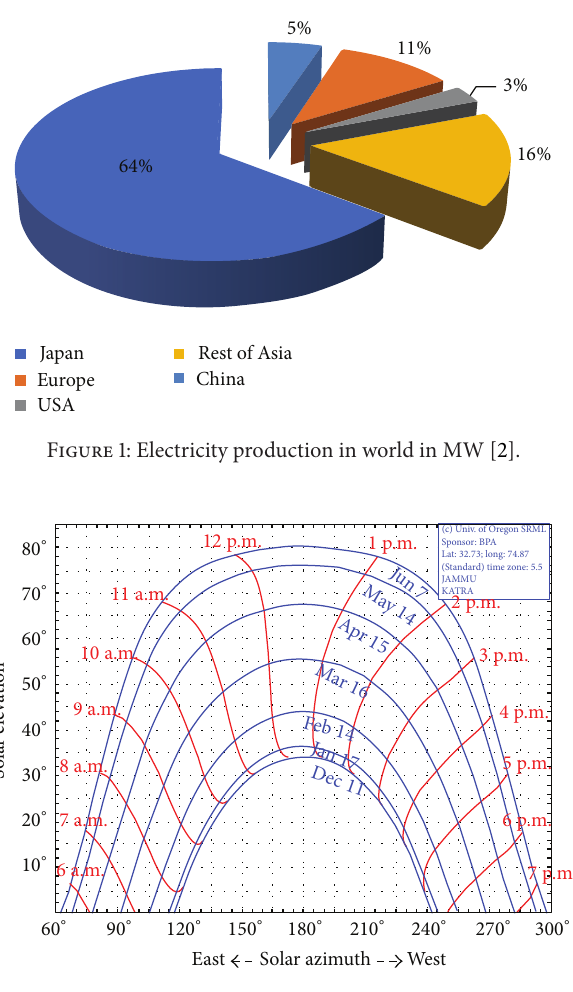
Figure 2: Average solar radiation from June to December [3].